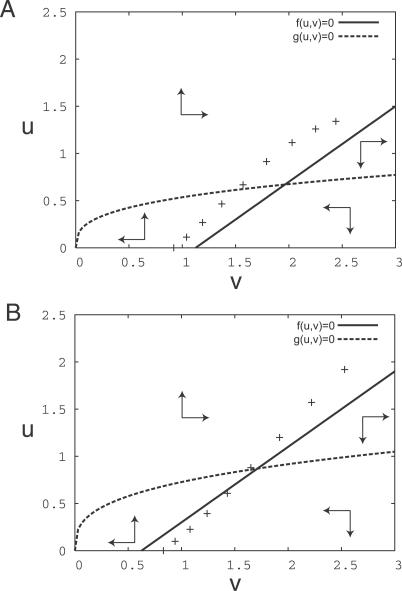
Typical Changes of u and v at the Tips of Branches(A,B) Representative data of the values of u and v were indicated on the phase plane, where direction of dynamics and null-cline of u and v are also shown (“A” for the cell of Figure 3A and “B” for that of Figure 3D). The data is sampled in every grid from the branch terminals. v increases linearly with u from the cell boundary to the interior of the cell. Solid lines and dashed lines represent f(u,v) = 0 and g(u,v) = 0, respectively. We have found that an elongation speed is about twice slower in rugged dendrites than in well-aligned ones (compare Videos S1 and S3). The difference in the positioning of the u − v values relative to the isoclines may potentially explain the difference in a velocity of pattern formation (our unpublished data).